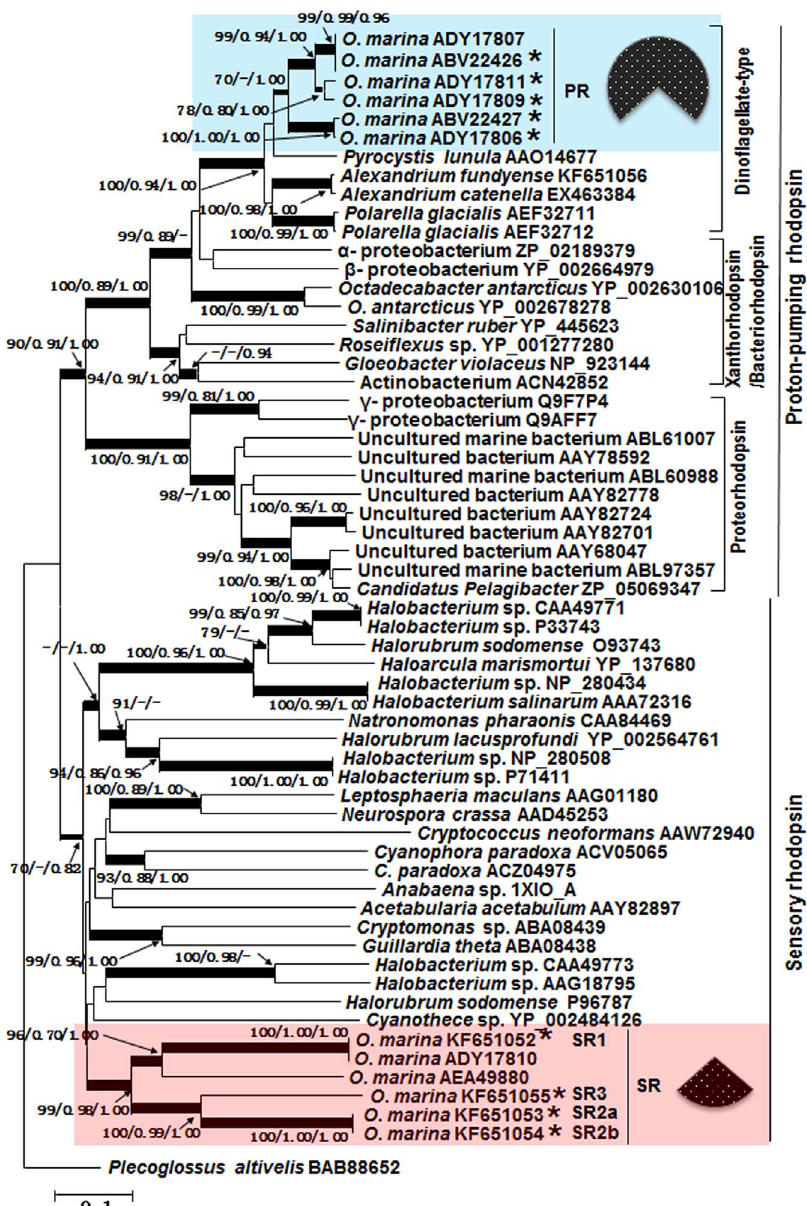
Fig. 1. Phylogenetic tree inferred from rhodopsin amino acid sequences. Shown at nodes are bootstrap values from Neighbor-Joining (left), SH-like value of maximum likelihood (medium) and Bayesian analysis (right); only values $ 70%/0.7 at critical nodes are shown. The thickest branches denote bootstrap values of . 90%, medium-thick branches values of 70 to 90%, and thin branches values of , 70%. The scale bar indicates the substitutions rate per nucleotide. Tree is rooted with Plecoglossus altivelis . The two major types, the proton-pumping (PR) and the sensory type (SR), are indicated on the far right while subgroups within PR are shown next. Pie slices indicate the relative transcript abundances of the two major types (with subtypes within each type combined) in terms of the percentage of reads. Asterisks depict sequences obtained in this study that were either new or matched previously reported sequences (accession numbers